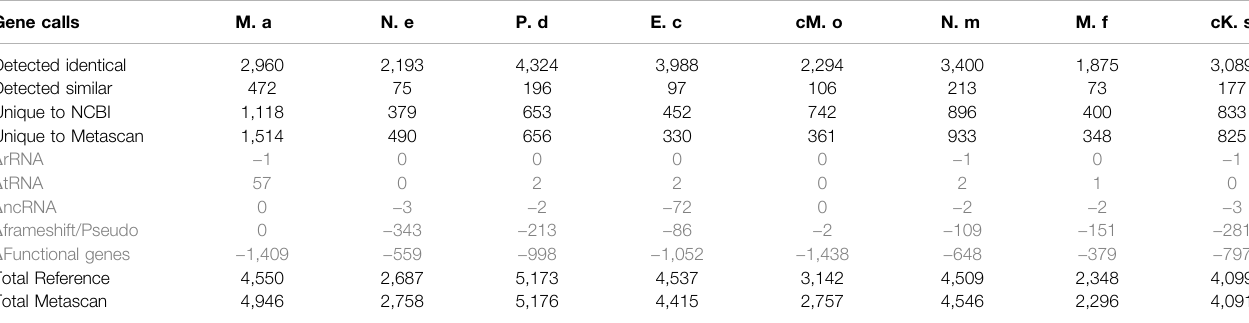
TABLE 6 | Direct and detailed comparison of the GenBank fi les from NCBI and Metascan. The differences in the grey area are related to the NCBI reference. Gene calls M. a N.